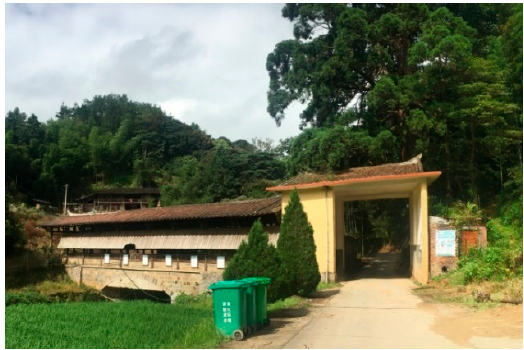
Figure 2. Water tail forests in Guifeng Village.